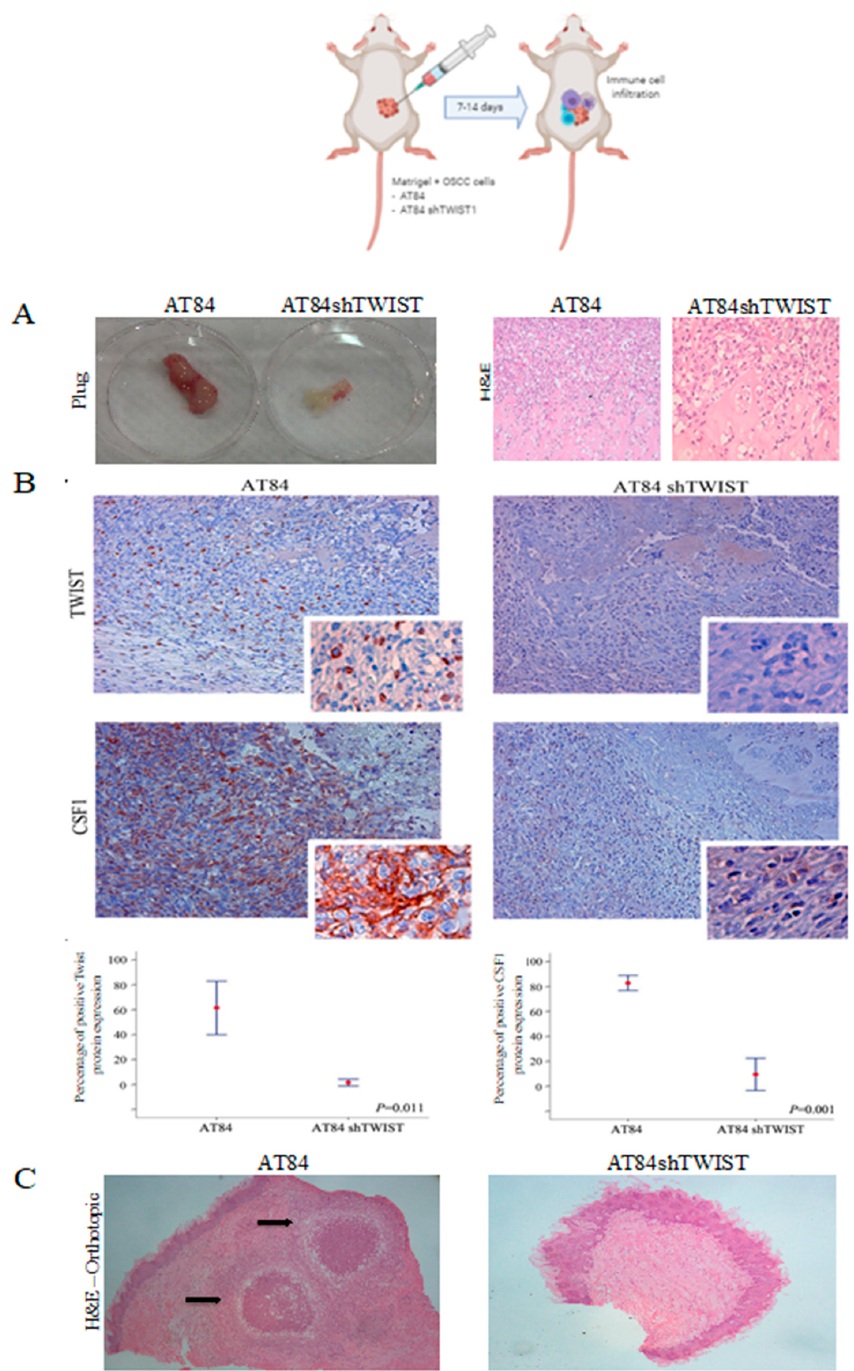
Figure 5. In vivo Matrigel plug assay and orthotopic model ( A ) Plugs obtained from mice 14 days after inoculation with Matrigel containing vehicle (control), AT84 cells and AT84 knockout TWIST1 were submitted to H&E. Original magnification: 20 × . ( B ) Immunohistochemistry images for TWIST1 and CSF1 proteins in AT84 control (left) and AT84 sh TWIST1 samples (right). Negative staining for TWIST1 and a week expression for CSF1 was observed in the tissues where AT84 sh TWIST1 was implanted; while a strong nuclear staining (for TWIST1) and cytoplasmic expression (for CSF1) was detected in the plug with AT84 cells. Original magnification: 20 × (large rectangle) 200 × (small rectangle). ( C ) H&E showing TWIST1 down-regulation inhibited tumor growth when AT84 cells were implanted either orthotopically into the tongues of mice and no clinical lesion could be observed (compared with AT84 control). Original magnification: 10 ×